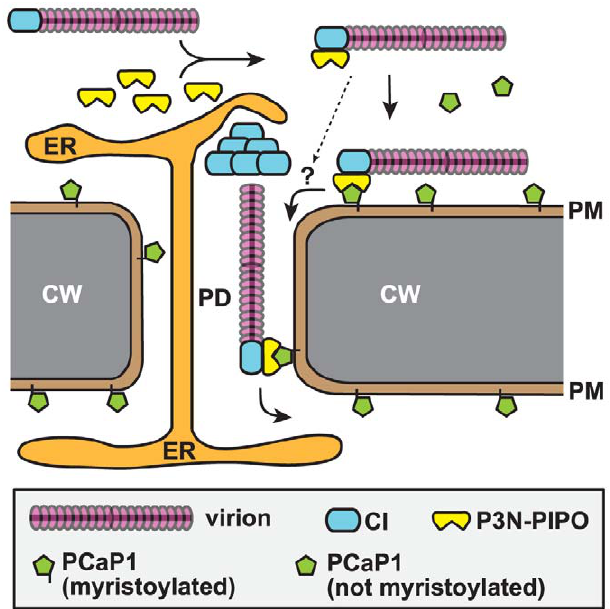
Figure 11. Hypothesis for the role of P3N-PIPO-PCaP1 interac- tion in potyvirus movement. We speculate that the virion-CI complex binds P3N-PIPO, via the CI protein. P3N-PIPO then transports the complex to the plasma membrane by binding PCaP1, which is anchored to the membrane via its myristoyl moiety. The PCaP1-bound complex accumulates in plasmodesmata possibly by the affinity of CI protein for the plasmodesmata, and/or via unidentified host proteins (question mark). Dashed arrow indicates possible route of inefficient movement of viral movement complex in PCaP1 knockout plants. ER, endoplasmic reticulum; PD, plasmodesmata; PM, plasma membrane; CW, cell wall.